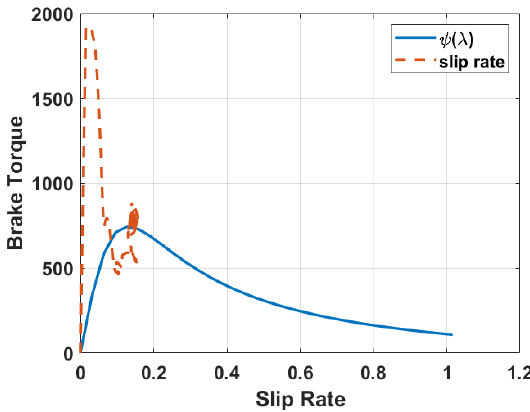
Figure 17. Closed-loop trajectory on ice